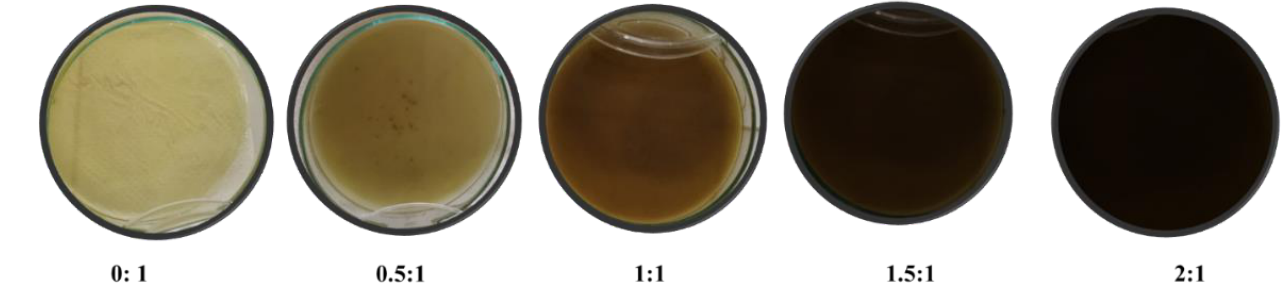
Figure 6. The A/UG film’s morphology changes as the proportion of wood ash to gelatin increases. When ash was added to A/UG films, a faint yellowish tint that had previously appeared in U/G films darkened. It is understood that the bonds formed between the amine groups of the gelatin and the hydroxyl groups of the glutaraldehyde, which result in the production of a Schiff base, cause the glutaraldehyde-promoted crosslinking to occur [28]. The primary visual characteristic caused by glutaraldehyde’s action in cross- linking the gelatin strands is a yellowish color. The color is caused by a Schiff base, which is identified by the presence of a C=N group in which the carbon is connected to two groups other than hydrogen atoms. This base is created when the NH 2 groups of some of the amino acids that make up the protein react with the C=O group of the aldehyde [29]; see Figure 7.